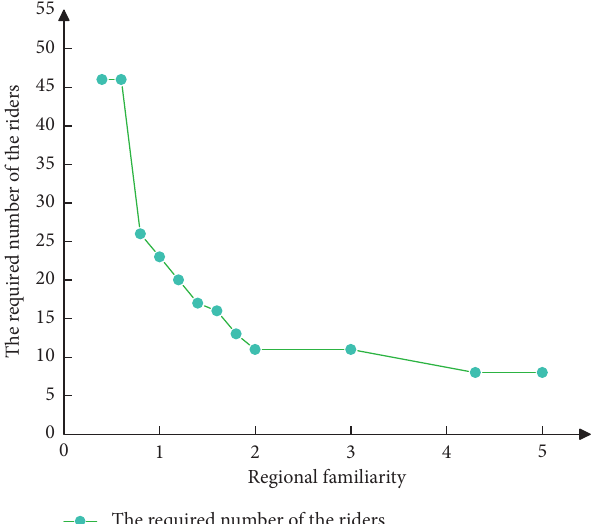
Figure 10: Relationship between regional familiarity and the re- quired number of